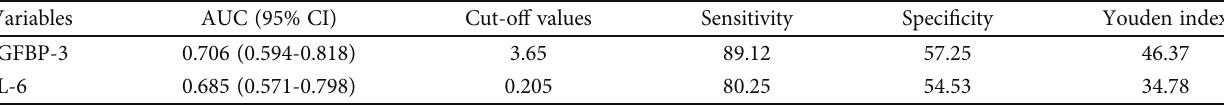
Table 3: Diagnostic value of IGFBP-3 and IL-6 for osteoporosis ( n = 85